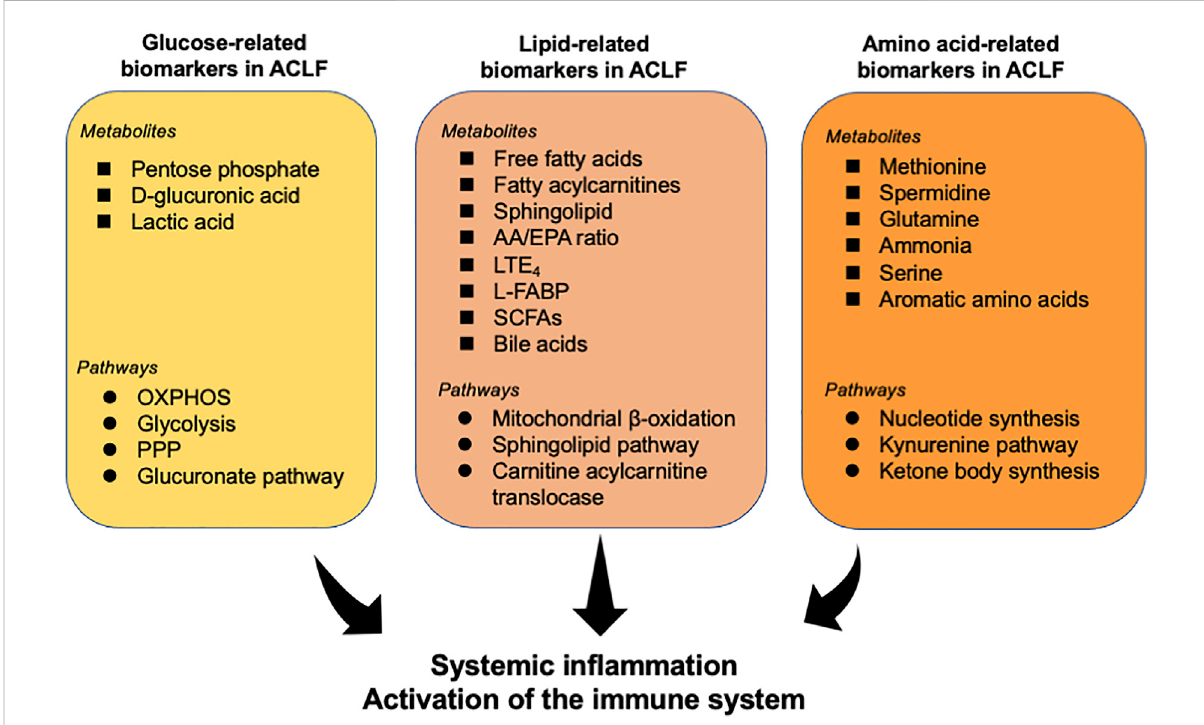
FIGURE 2 Overview ofmetabolites andrelated pathwayswhichhavebeen identi fi edtoberobust biomarkersfor ACLF.Variousmetabolitesand pathways